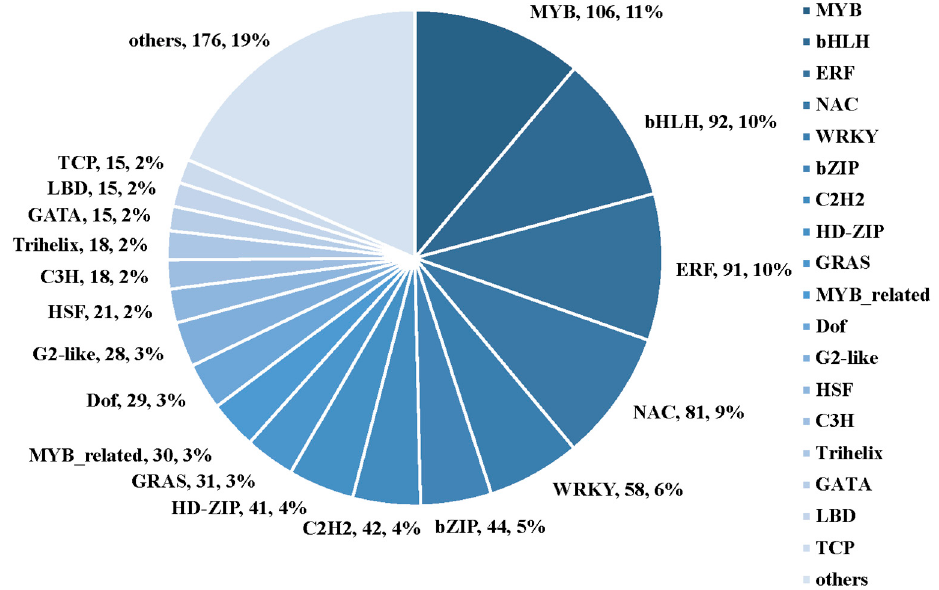
Figure 12. The distribution of TFs genes families. The size of the sector represents the frequency of each TFs. Top five TFs are the MYB, bHLH, ERF, NAC, and WRKY family, which might be involved in response to the drought stress.